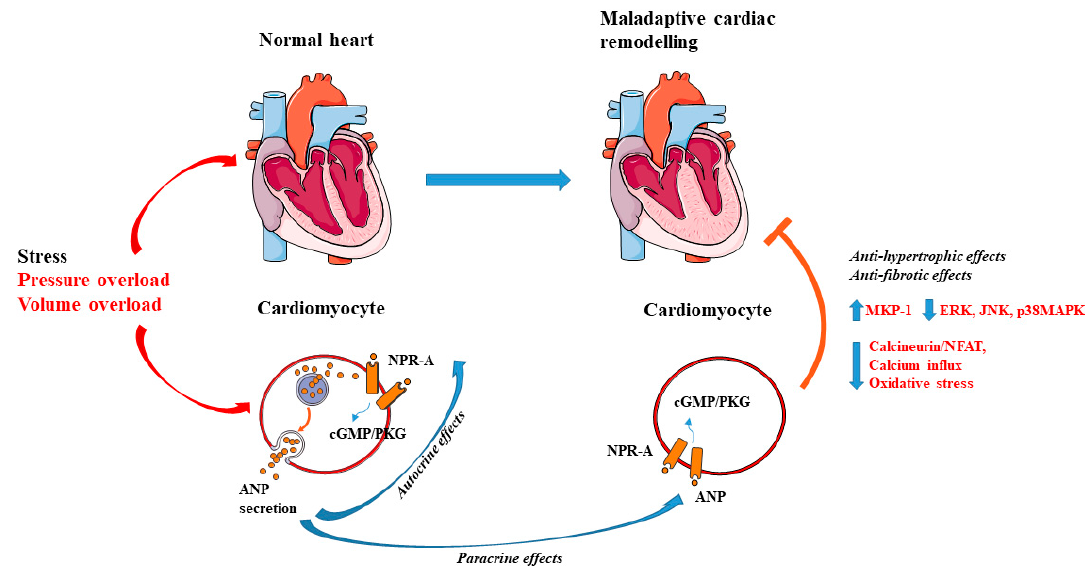
Figure 1. Local action of atrial natriuretic peptide (ANP) in cardiomyocytes. ANP is secreted by cardiomyocytes in response to cardiac stress. After secretion, ANP binds to the natriuretic peptide receptor (NPR-A) and activates the cGMP/PKG pathway. Anti-hypertrophic and anti-fibrotic effects of ANP occur through autocrine and paracrine mechanisms. Arrow-headed lines indicate activation, whereas bar-headed lines indicate inhibition. Legend: c-Jun N-terminal kinase (JNK); cyclic guanosine monophosphate (cGMP); extracellular signal-regulated kinase (ERK); mitogen-activated protein kinase phosphatase-1 (MKP-1); natriuretic peptide receptor type A (NPR-A); nuclear factor of activated T-cells (NFAT); p38 mitogen-activated protein kinase (MAPKs); protein kinases G (PKG). See text for further details. The figure was made using tools provided by Servier Medical Arts, amongst others.